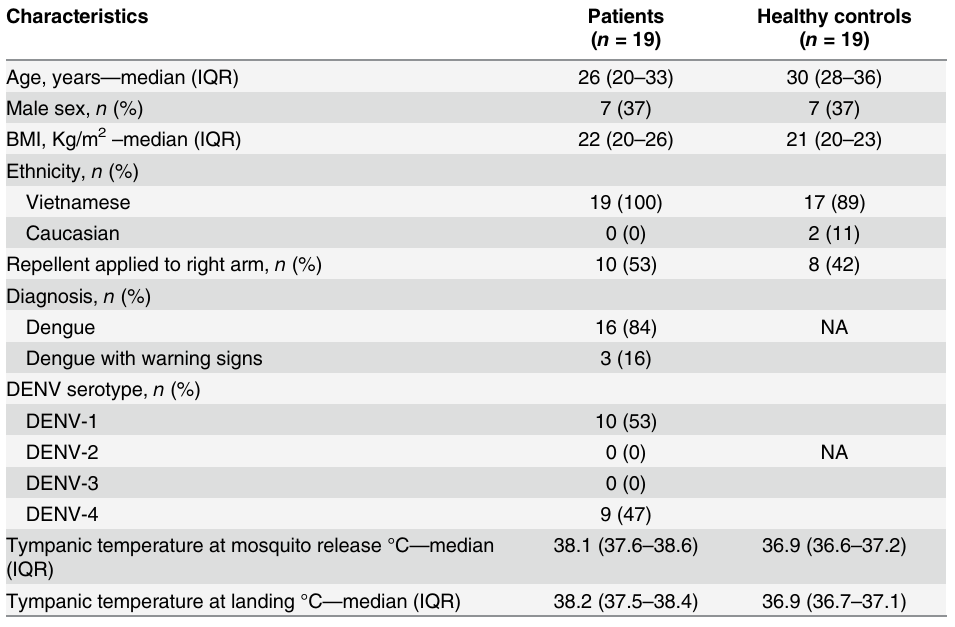
Table 5. Baseline characteristics of participants in repellent